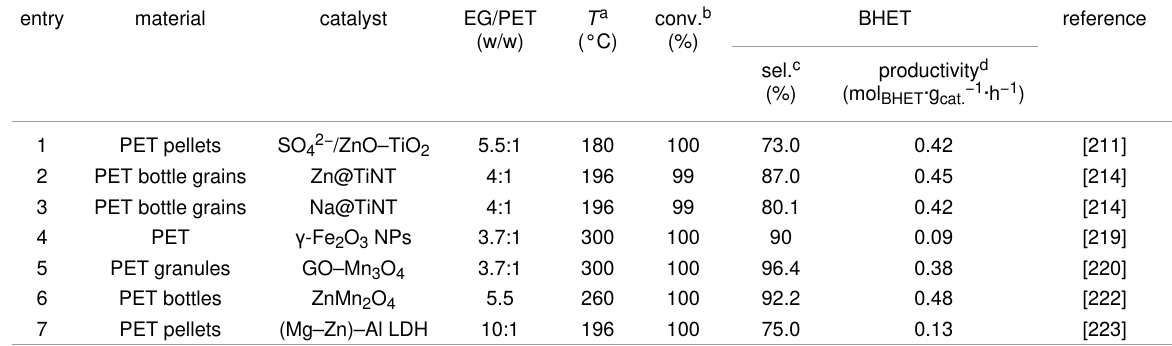
Table 3: Glycolysis of PET using EG and insoluble, solid-supported metal catalysts.